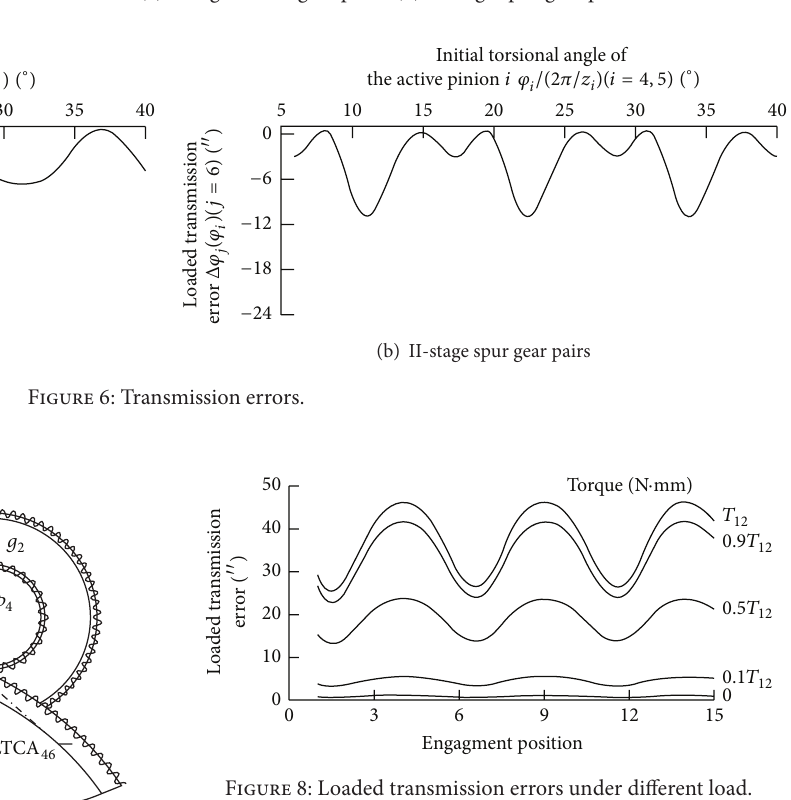
Figure 5: Load distribution on the tooth surface. (a) I-stage helical gear pairs. (b) II-stage spur gear pairs.